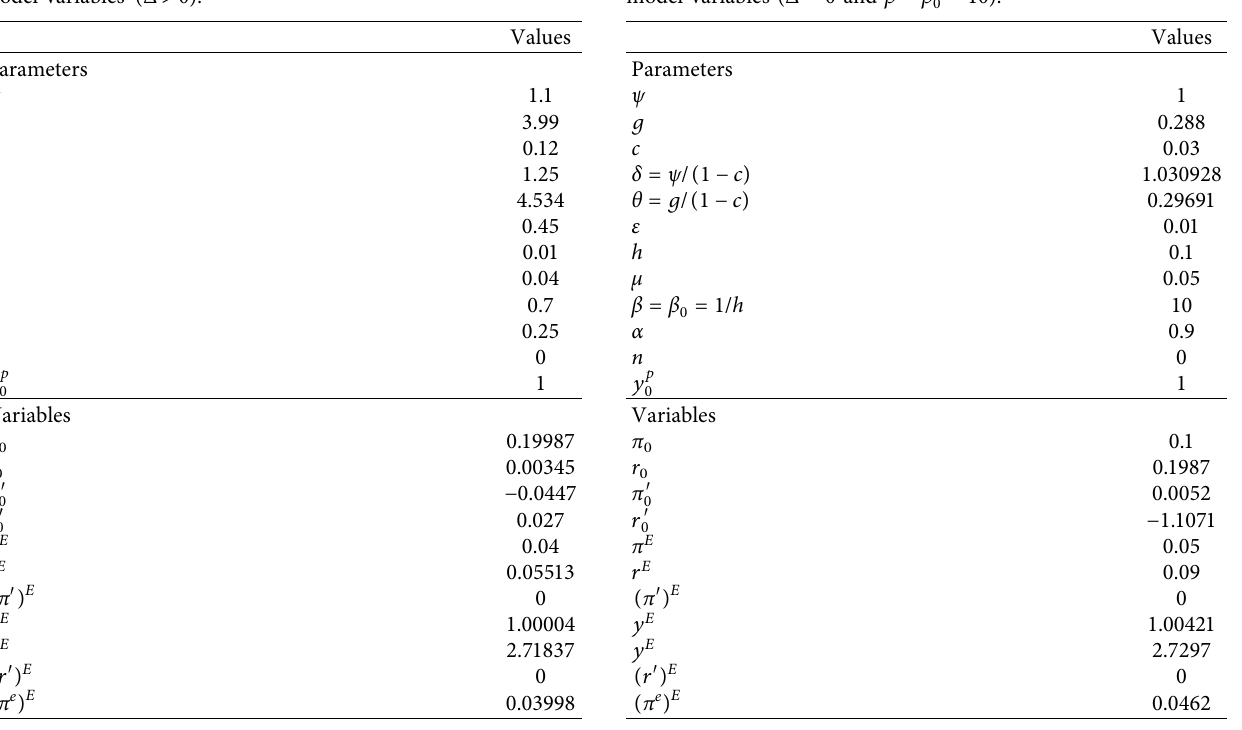
Table 4: Parameter values and initial and equilibrium values of the